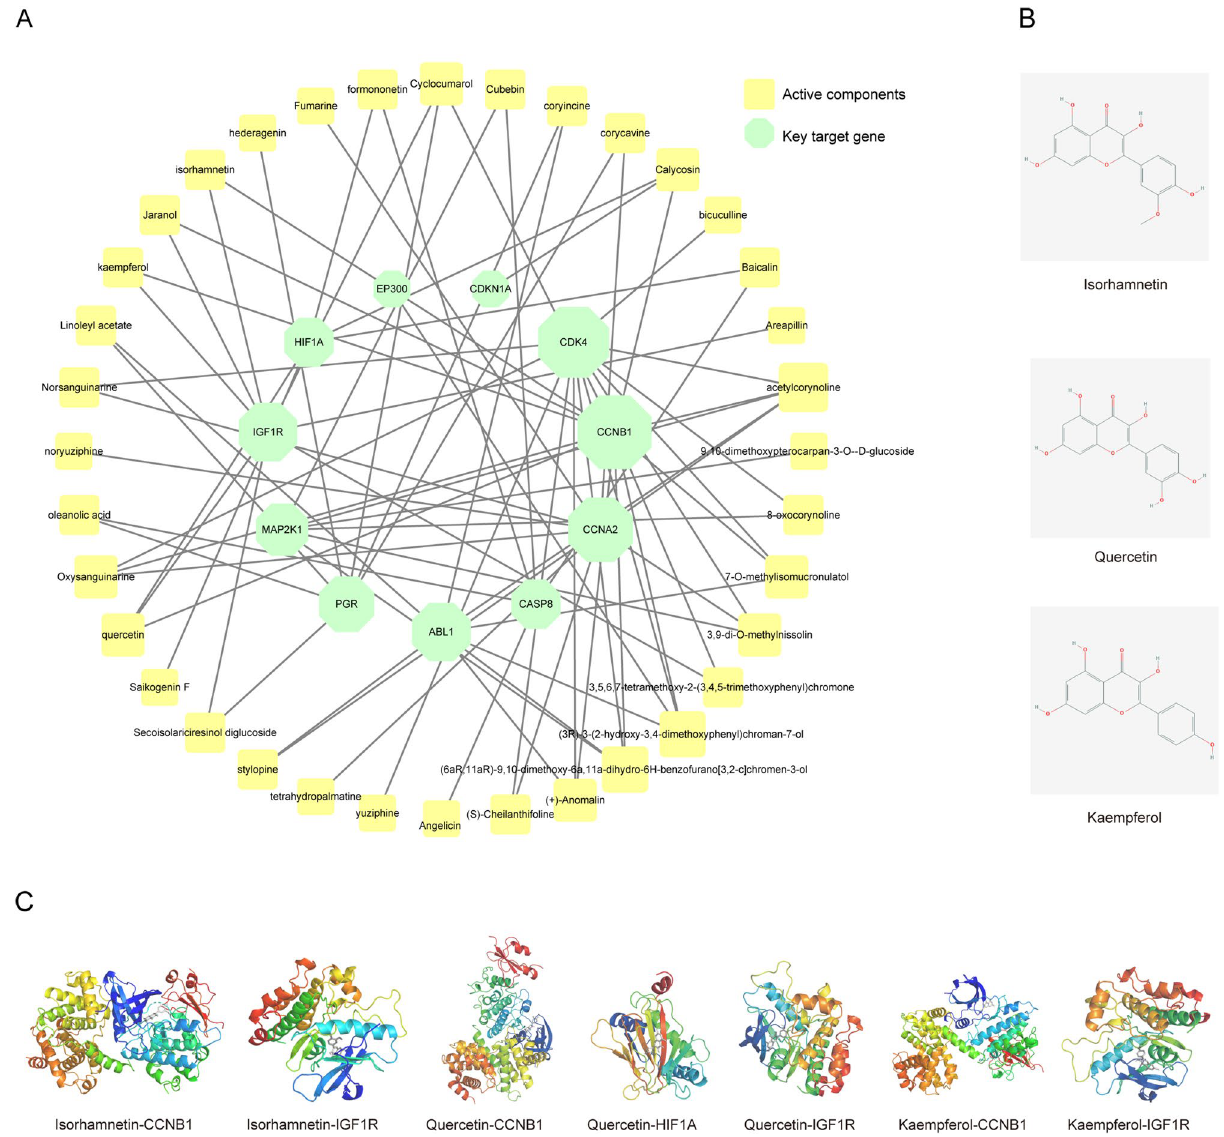
Figure 5. The molecular docking of key compounds and key target genes. ( A ) Interaction network of key target genes and corresponding active compounds of prediction. The green octagons represent key target genes, the yellow squares represent active compounds of prediction. The size of the icon was set according to the degree of the network. [drawn by Cytoscape 3.8.0 (https:// www. cytos cape. org/)]. ( B ) The structure of key compounds. ( C ) The molecular docking of key compounds and key target